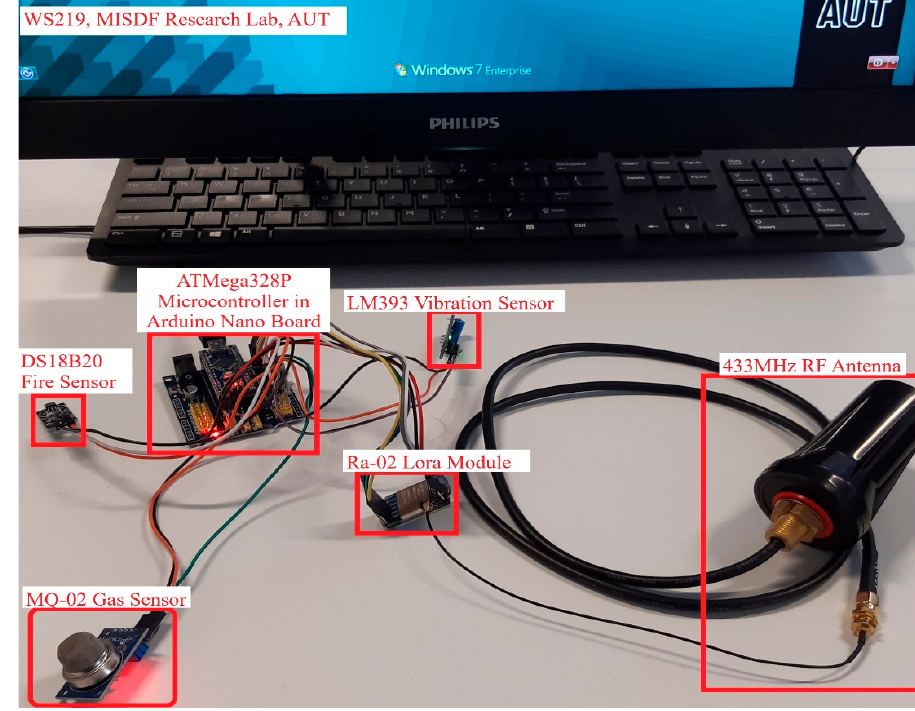
Figure 3. Illustrating the LoRa transmitter node–01 (prototype).